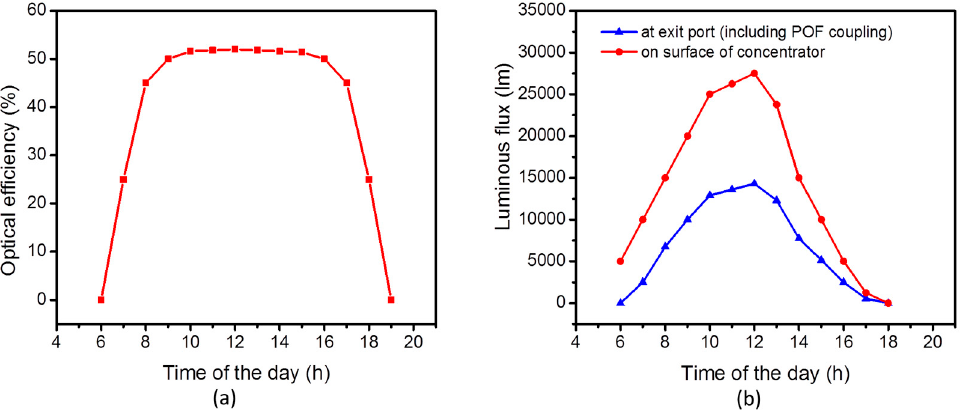
Figure 10. Flat OFDS performance over the course of the day including POF coupling loss. ( a ) The optical efficiency and output luminous flux changes depending on the position of the sun in the sky; ( b ) The dependence of luminous flux on the surface of the sunlight concentrator and the output at the exit port at different times during a sunny day.